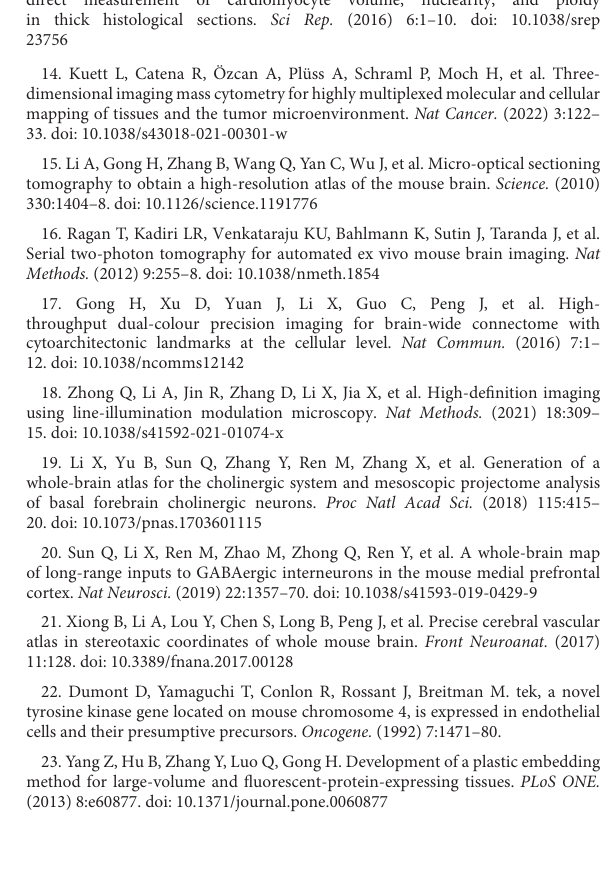
SUPPLEMENTARYFIGURE1 Image of a cardiac slice stained by PI and DAPI fluorescent dyes. Scale bars: 50 µ m. SUPPLEMENTARYFIGURE2 Segment a myocardial fiber and five nuclei from Figure 2D and quantify the volume of these cardiomyocyte nuclei.